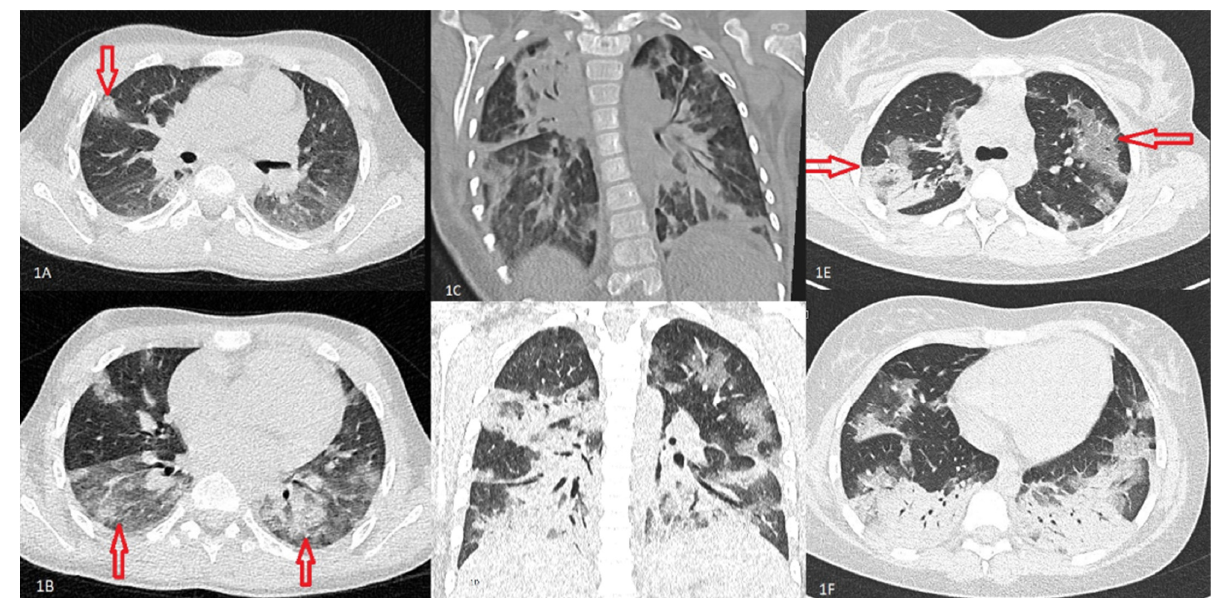
Figure 1. Chest computed tomography results in children with COVID-19. ( A ) Patient X—10-year old girl with Down syndrome. Chest CT scan, axial lung window, consolidation with irregular margins (arrow). ( B ) Patient X—10-year old girl with Down syndrome. Chest CT scan, axial lung window, ground-glass opacities (arrows). ( C ) Patient Y—15-year old boy with cerebral palsy. Chest CT scan, coronal lung window, large bilateral consolidations predominantly posteriorly and air bronchograms bilaterally. ( D ) Patient Z—13-year old girl, no comorbidities. Chest CT scan, coronal lung window, patchy areas of ground glass and consolidative changes. The lesions were bilateral predominantly posteriorly, reverse halo pattern in the right upper lobe. ( E ) Patient Z—13-year old girl, no comorbidities. Chest CT scan, axial lung widow, left lung diffuse ground-glass opacities with intralobular reticulation not affecting the peripheral cortex of the lung right lung ground-glass opacities and consolidative changes and air bronchograms (arrows). ( F ) Patient Z—13-year old girl, no comorbidities. Chest